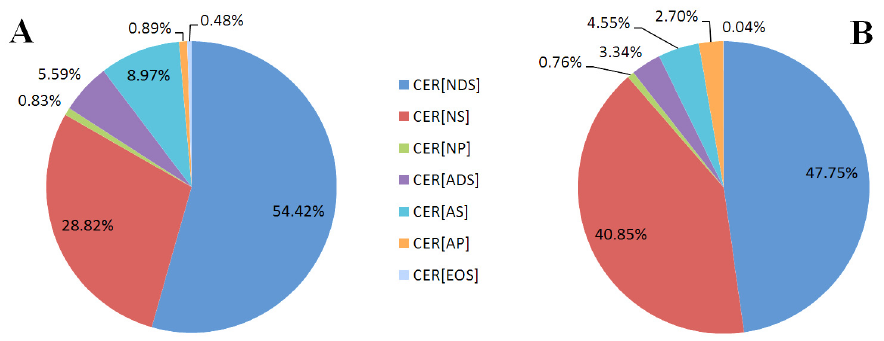
Figure 2. The proportions of ceramide families in the keratinocytes ( A ) and fibroblasts ( B ) of healthy subjects; (non-hydroxy fatty acid [N], α -hydroxy fatty acid [A], and esterified ω -hydroxy fatty acid [EO], dihydrosphingosine [DS], sphingosine [S], and phytosphingosine [P]).